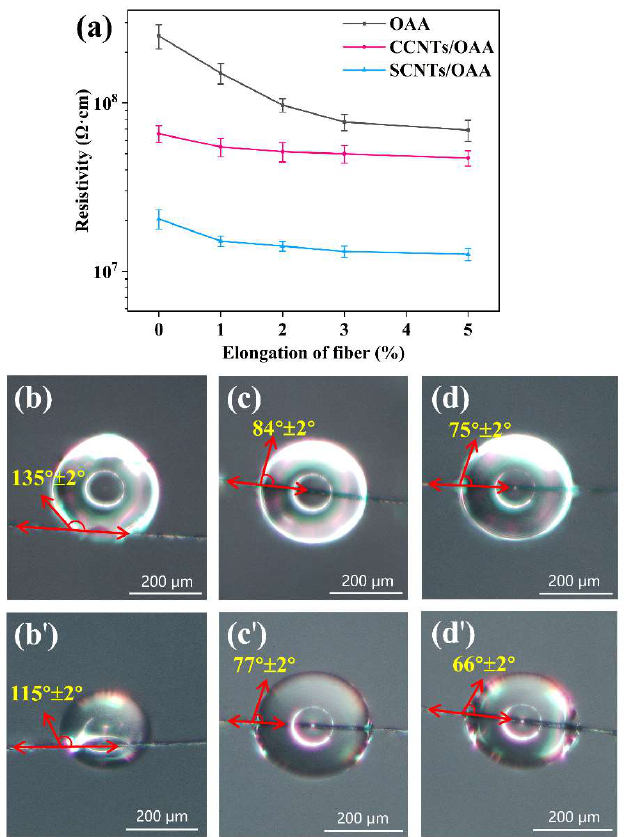
Figure 7. ( a ) Resistivity of fiber with different elongation; the contact angle of ( b , b ’) OAA-treated fiber, ( c , c ’) CCNTs/OAA-treated fiber, and ( d , d ’) SCNTs/OAA-treated fiber with water ( b , c , d ) and ethylene glycol ( b ’, c ’, d ’), respectively. Table 2. The surface energy of fibers.